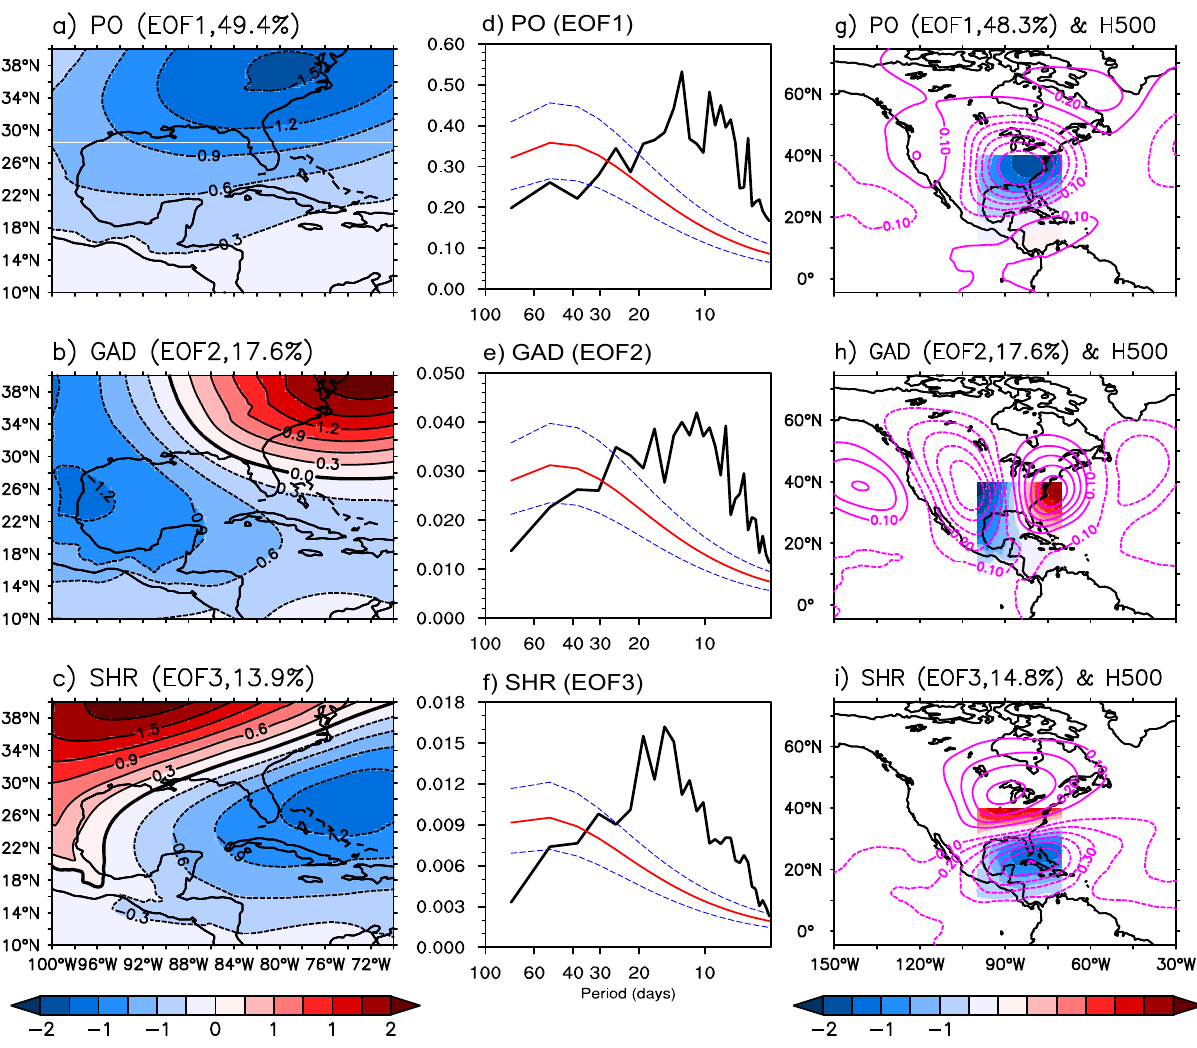
Fig. 2 The leading circulation modes and their power spectra. a – c the leading EOF modes of 3-day running mean 850 hPa geopotential height (H850) anomalies. d – f the power spectra of the fi rst three modes shown in a – c , with the upper and lower blue dashed lines representing the 95% and 5% con fi dence limits for this red noise. Note that the spectra are calculated for individual hurricane seasons and is then averaged over multiple years. g – i the fi rst three modes of band-pass fi ltered (10 – 35 days) H850 anomalies (shading, the EOF domain and colorscale are the same as a – c ), and the simultaneous correlation between the PCs and the band-pass fi ltered (10 – 35 days) 500 hPa geopotential height anomalies